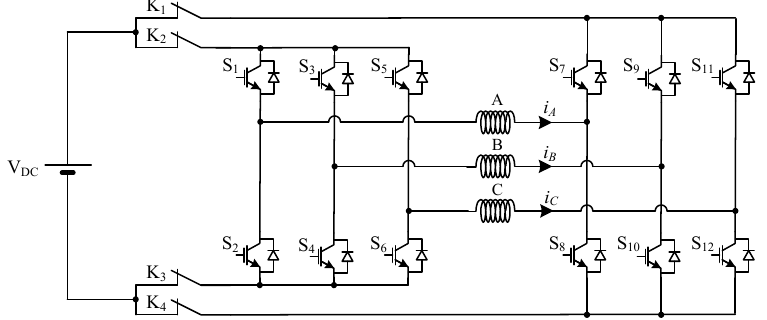
Figure 27. Fault-tolerant topology proposed by [92] using two standard six-pack switch modules and isolation relays (mechanical switches) to isolate short-circuit failures in controlled power semiconductors. Both open- and short-circuit failure modes are covered in this topology.